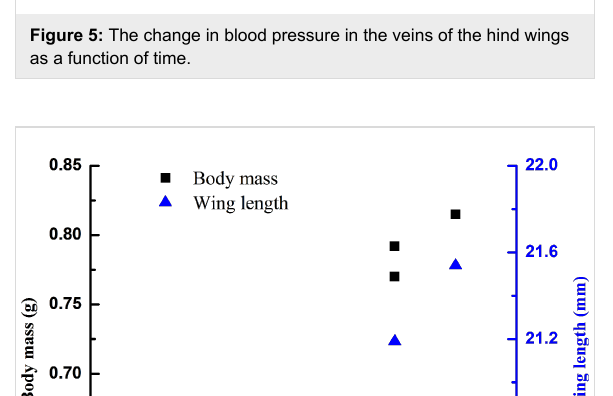
peak pressure of 1.4 Pa, which made the hind wing fully expand after some time of fluctuation (alternating high and low pres- sures, 1.4 Pa, − 1.08 Pa, − 1.3 Pa, − 0.96 Pa, − 1.16 Pa, − 0.9 Pa, − 1.2 Pa), at 2.562 s, the pressure reached 1.2 Pa. Then, the pres-